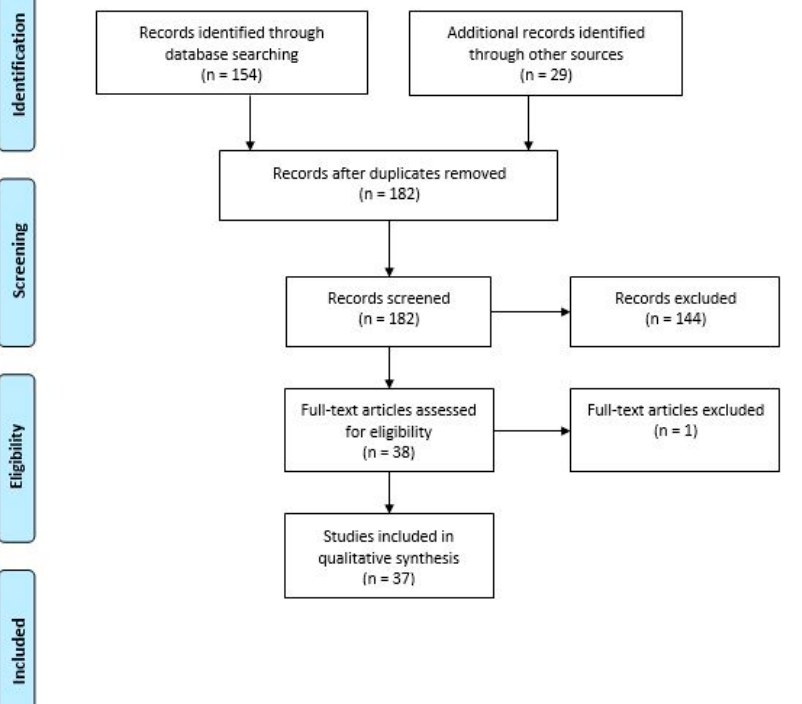
Figure 1. Flow diagram of the literature search strategy and review process, following PRISMA 2009 flow diagram rules.